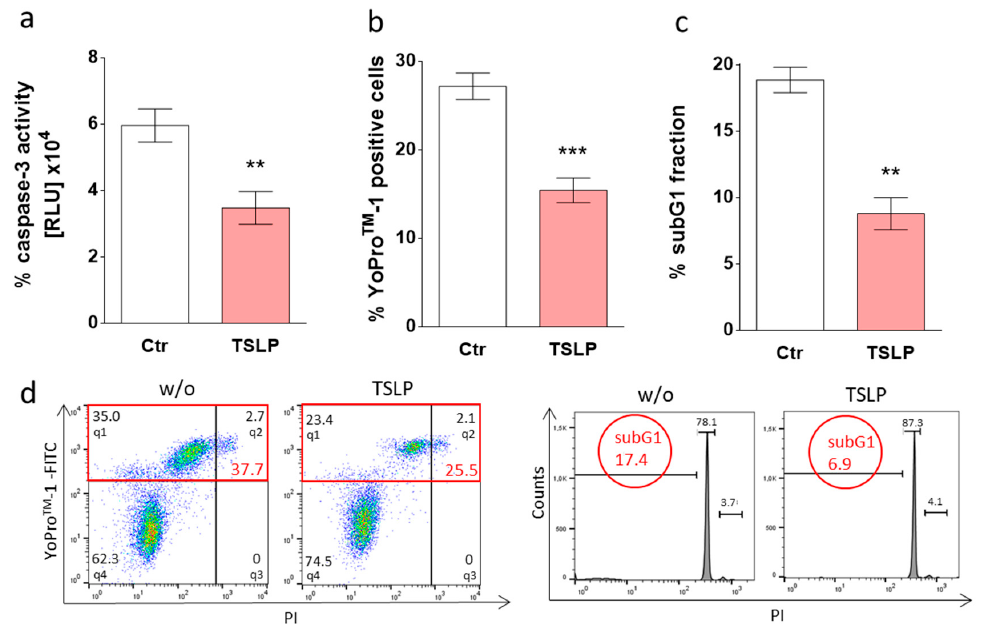
Figure 1. Thymic stromal lymphopoietin (TSLP) counters apoptosis of skin mast cells (MCs) upon grow factor (GF) withdrawal. Skin-derived MCs were kept without or with TSLP (at 7.5 ng / mL) in serum / GF-free medium. ( a ) Caspase-3 activity as determined after 24 h by Caspase-Glo ® 3 / 7 assay; the results represent the mean ± SEM of six independent experiments. RLU = relative luminescence units ( × 10 4 ). ( b , c ) Percentage of cells with ( b ) YoPro TM -1 positivity (corresponding to the percentage of early and late apoptotic / necrotic cells combined) after 24 h or ( c ) fragmented DNA (propidium iodide (PI) staining, corresponding to the percentage of subG1 positive cells) after 48 h. The results represent the mean ± SEM of six (YoPro TM -1) or four (PI) independent experiments. ( d ) Representative flow cytometry dot plots / histograms of ( b ) (specified in red is the percentage of early and late apoptotic / necrotic cells combined) and ( c ). The data were analyzed by paired t -test, ** p < 0.01, *** p < 0.001. q —quadrant.